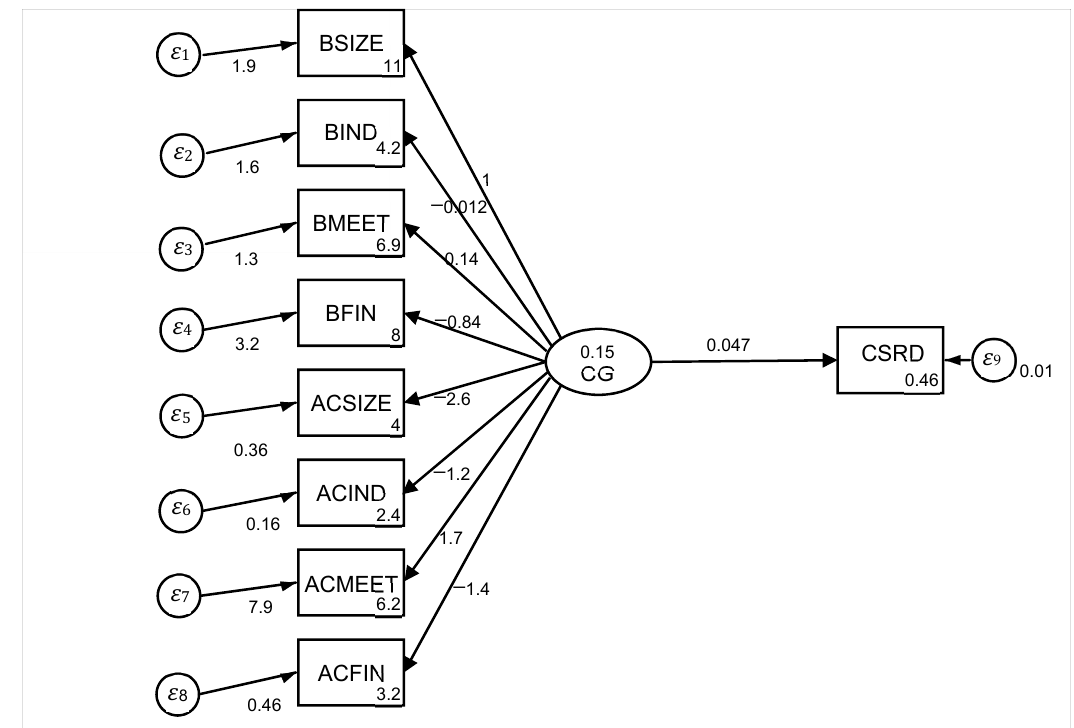
Figure 2. Result of corporate governance and corporate social responsibility disclosure. Table 1. Result of corporate governance and firm performance. STRUCTURAL